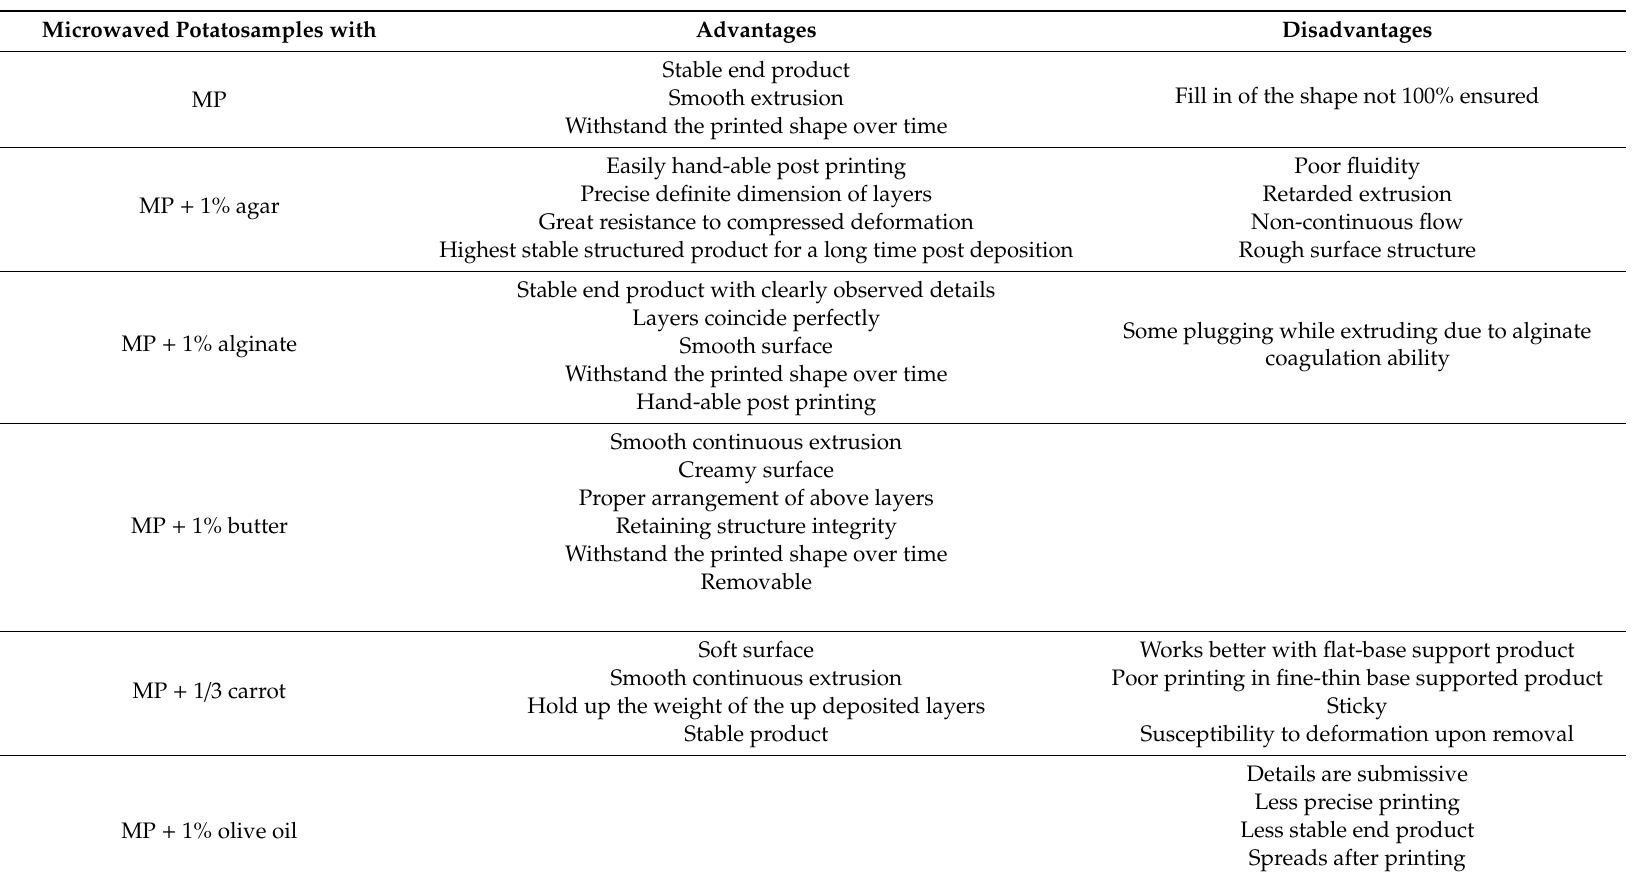
Table 3. E ff ect of additives on microwaved potato samples feasibility during 3D